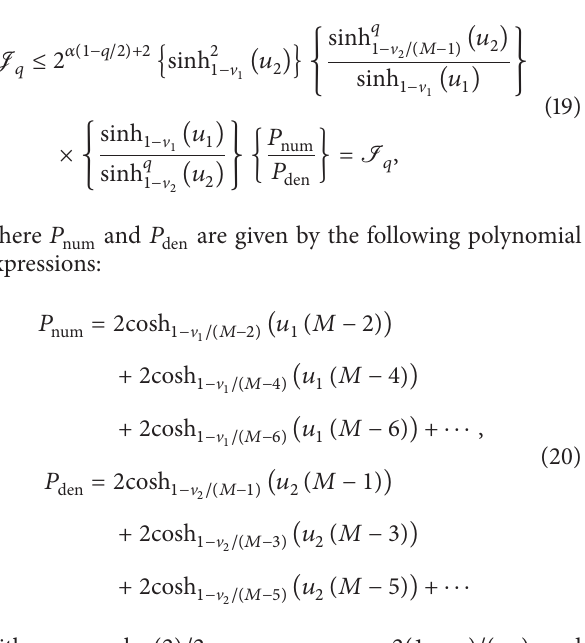
equal at 𝛼 = 0 and some similar behaviour are observed for different values of the parameter 𝑞 . The above results allow